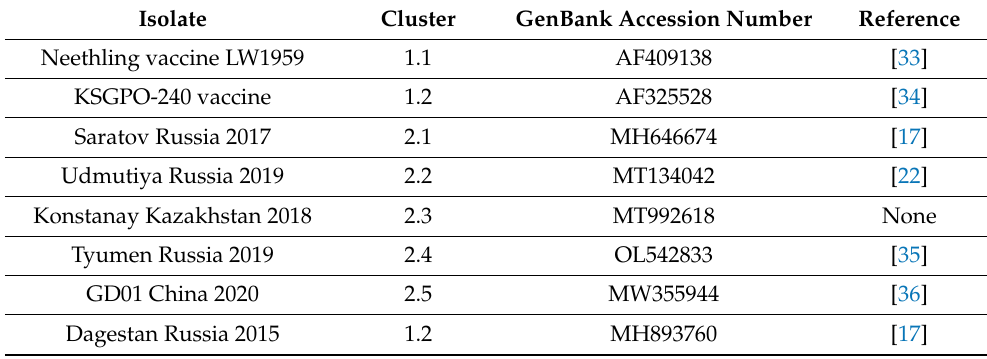
Table 1. Whole-genome sequences retrieved from GenBank and used to design a single polymerase chain reaction (PCR) and sequencing assay. Isolate Cluster GenBank Accession Number Reference Neethling vaccine